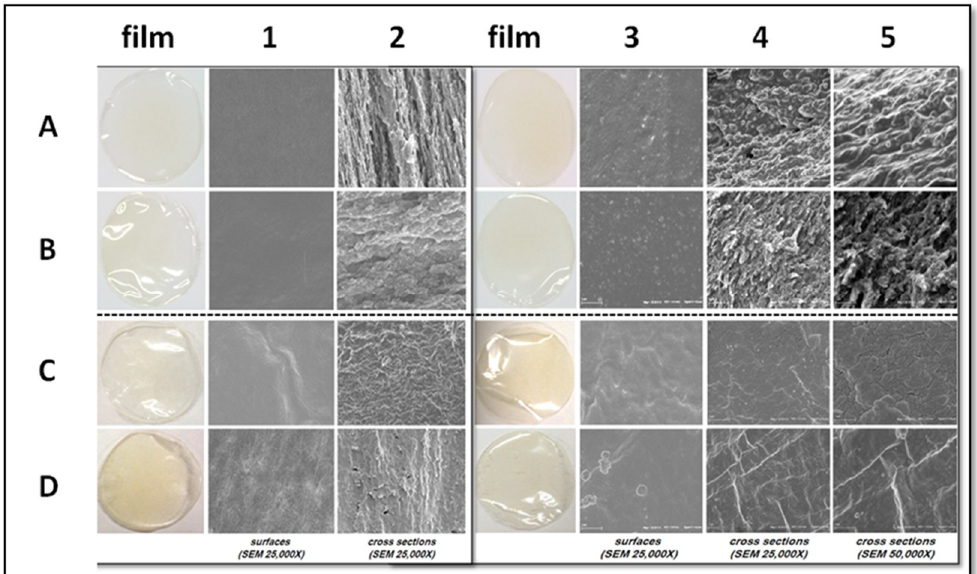
Figure 1. SEM morphology of the PEC ( A,B ) and the CH ( C,D ) films, prepared in the absence ( A1,A2,C1,C2 ) or presence of either GLY ( B1,B2,D1,D2 ), MSN ( A3–5,C3–5 ), or both GLY and MSN ( B3–5,D3–5